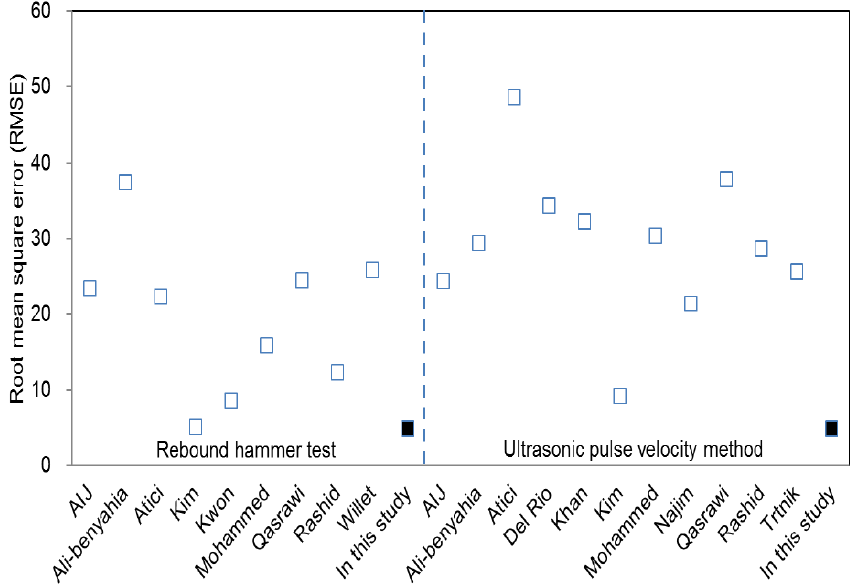
Figure 6. Root mean square error of the compressive strength of concrete.